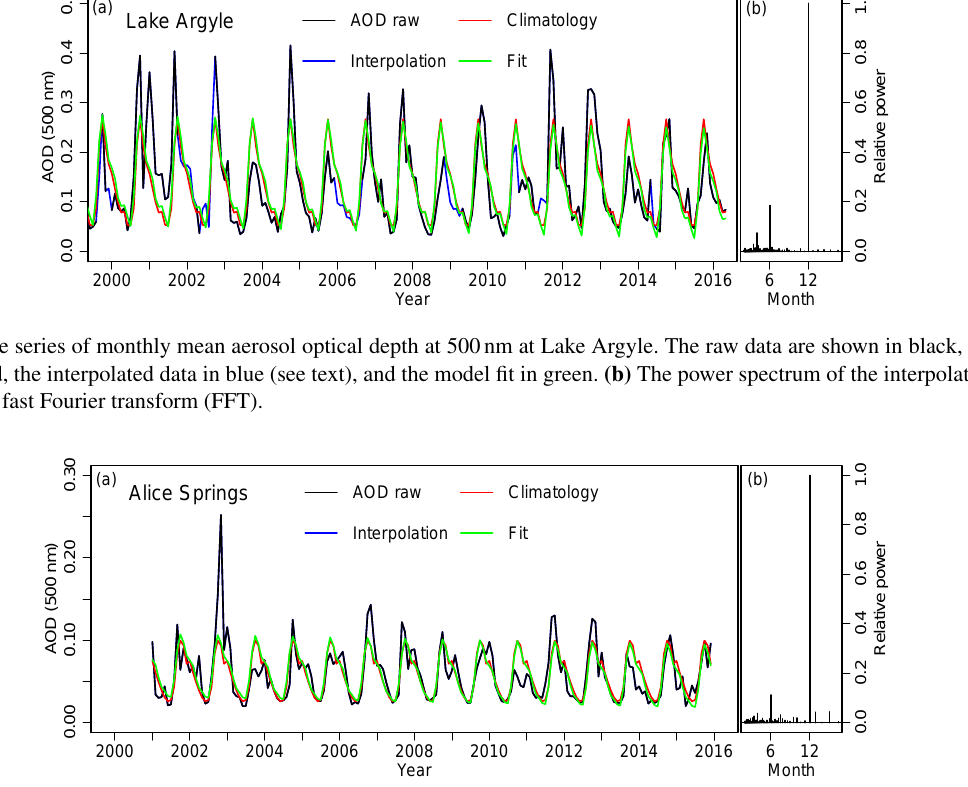
Figure 3. (a) Time series of monthly mean aerosol optical depth at 500nm at Alice Springs. The raw data are shown in black, the (repeated) climatology in red, the interpolated data in blue (see text), and the model fit in green. (b) The power spectrum of the interpolated time series computed using a fast Fourier transform